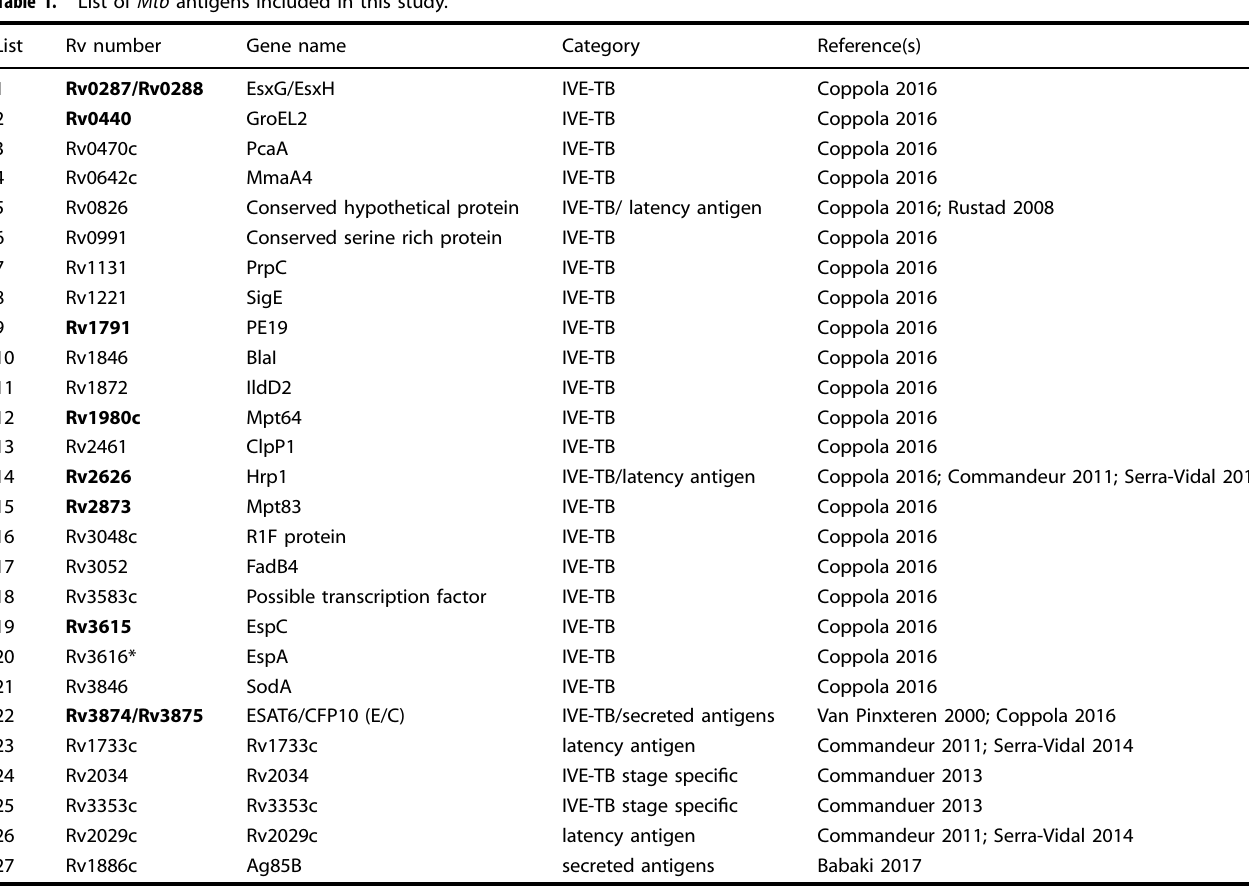
Table 1. List of Mtb antigens included in this